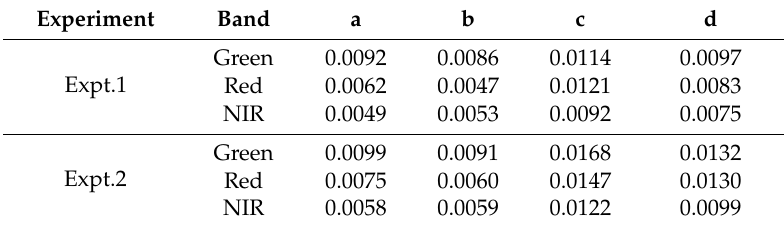
Figure 8. Selection of homogeneous/heterogeneous areas. Homogeneous areas: ( a ) mainly distributes cultivated land and ( b ) mainly distributes bare land. Heterogeneous areas: ( c ) mainly distributes residential land, cultivated land, and water; and ( d ) mainly distributes wetland and water. Table 6. The estimation accuracy of reflectance in homogeneous/heterogeneous areas. Experiment